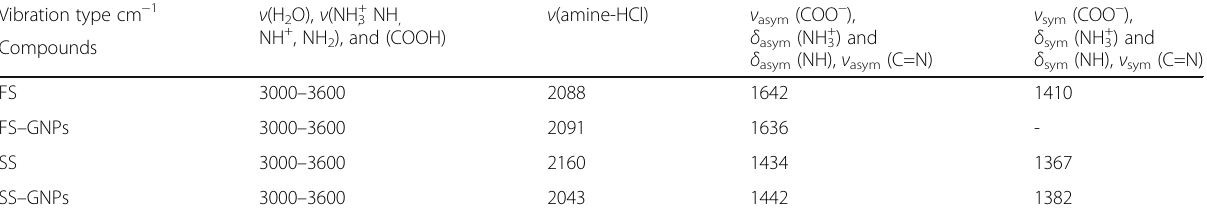
Table 2 FTIR bands of FS, FS – GNPs, SS, and SS – GNPs Vibration type cm −